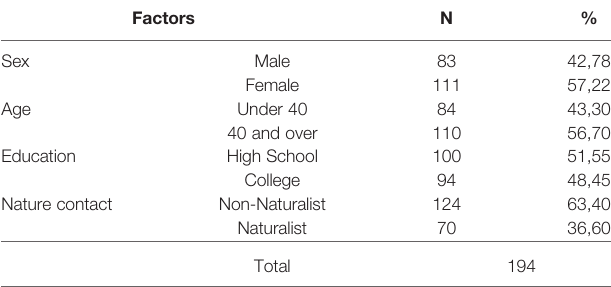
TABLE 1 | Tourist participation in the Glocal Education project.